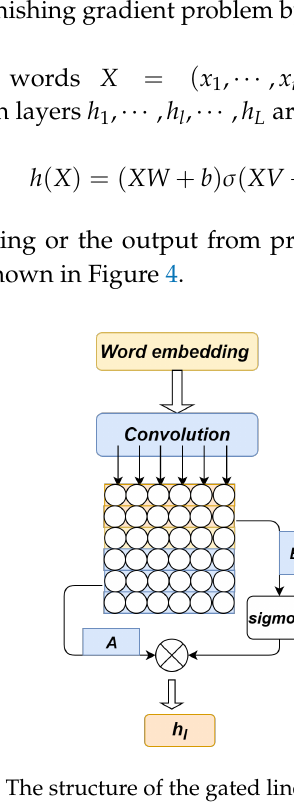
Figure 5. The overall architecture of our model. Our algorithm contains two stages, E1 prediction and multi-turn E2 prediction, and the relations are predicted together with E2 in the second stage. 3.1. E1 Prediction 3.1.1. Gated Linear Dilated Residual To begin, we need to transform a variable-length sentence into a fixed-length vector. Given a sentence S = ( w 1 , . . . , w i , . . . , w n ) , where w i denotes the i th word in S , we embed it as a matrix X . We combine position information with word embedding, as it is useful in our architecture. The gated linear dilated residual (GLDR) used in our model is not the same as that used in Wu et al. [15]. Instead of increasing the dilation rate exponentially, we set it as ( 1, 2, 5, 1, 2, 5, 1, 2, 5, 1, 1, 1 ) ; the reason for this is detailed in Section 2. Similar to ResNet [32], we sum the output of GLU and the input X : M = X + ( XW + b ) σ ( XV + c ) , (3) where X is the input from the previous layers and W , V , b , c are learned parameters. Note that after learning in several layers, the receptive field (RF) is sufficiently wide for the task, so we set the dilation rate to 1 for the last three layers for further refinement.